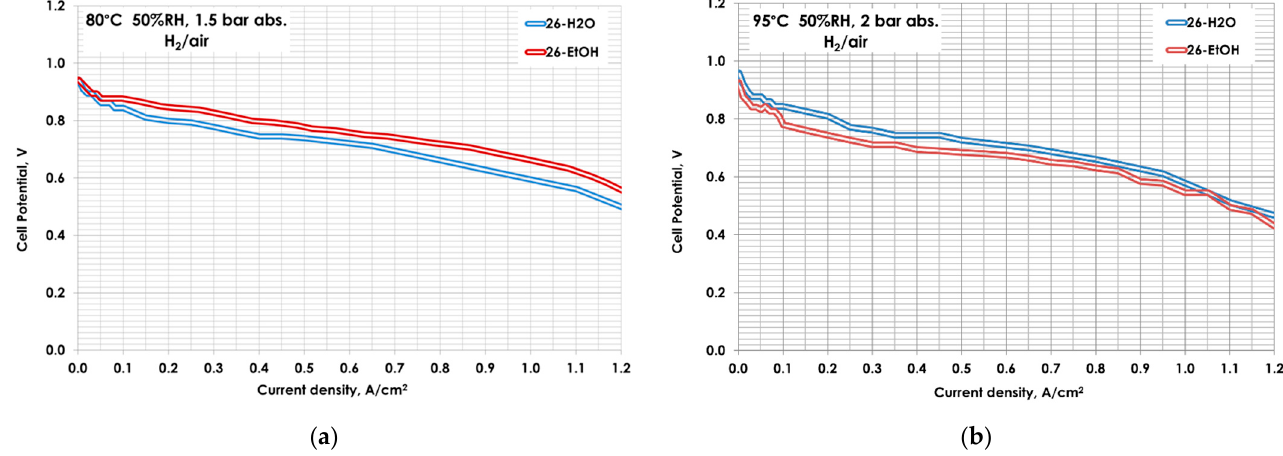
Figure 4. Polarization curves for 26-H 2 O and 26-EtOH at ( a ) 80 °C 50 RH% and 1.5 bar abs ( b ) 95 °C 50 RH% and 2 bar abs .